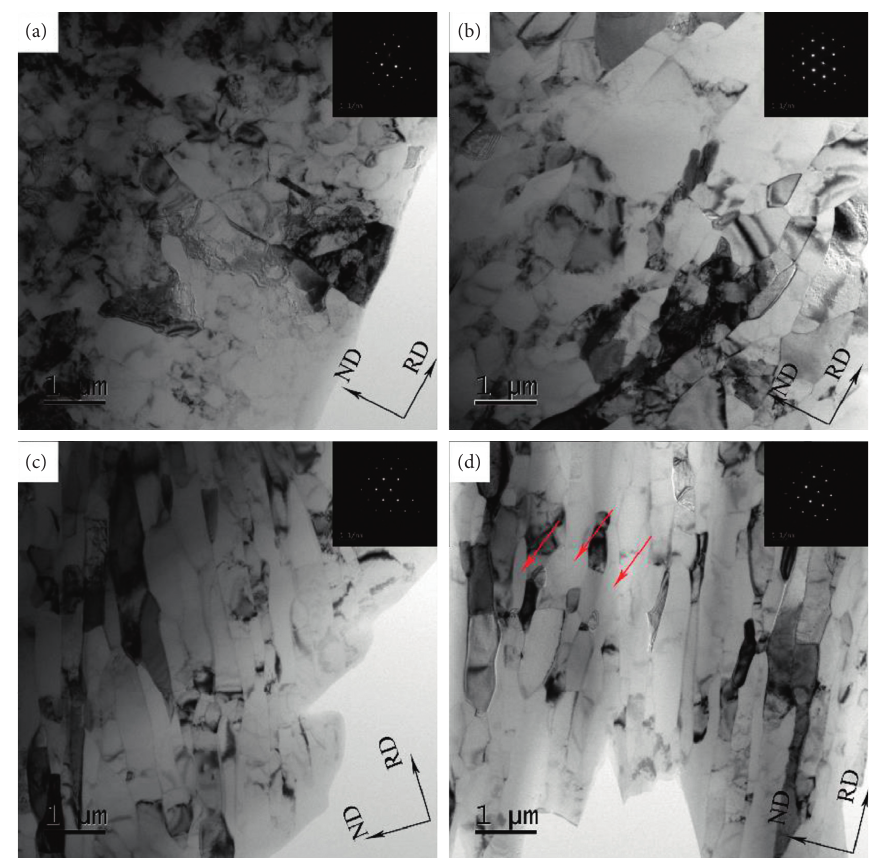
Figure 7: TEM micrographs on the RD-ND plane of Al in the Al-Nb/Ti/Ni composites: (a) 1st pass, (b) 2d pass, (c) 3rd pass, and (d) 4th pass.